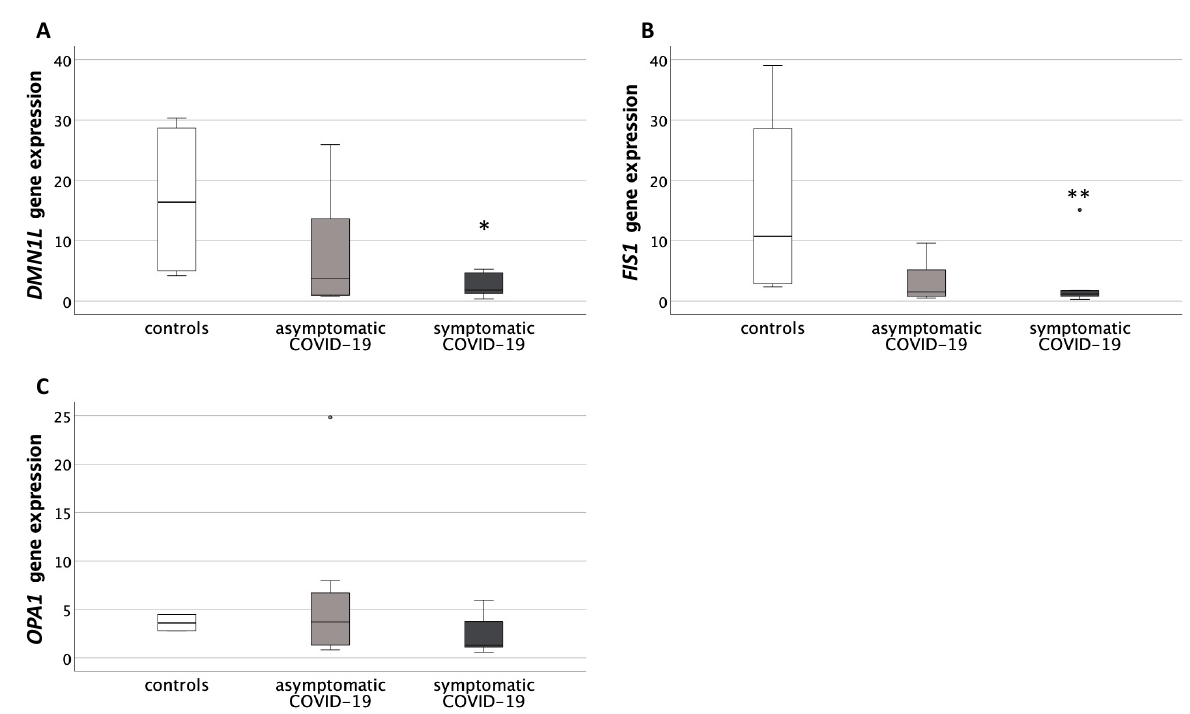
Figure 4. Expression levels of genes related to the mitochondrial dynamics of fusion and fission in placentas from healthy control pregnancies and mothers infected with SARS-CoV-2 during the third trimester of pregnancy. ( A ) Placental Pro-Fission Dynamin-1-like Protein ( DNM1L ) gene expression levels. Data were significantly different among the three groups (Kruskal-Wallis test, p < 0.05). * p < 0.05 vs. controls (Mann-Whitney U test). ( B ) Placental Fission 1 Protein ( FIS1 ) gene expression levels. Data were significantly different among the three groups (Kruskal-Wallis test, p < 0.05). ** p = 0.01 vs. controls (Mann–Whitney U test). ( C ) Placental Pro-Fusion mitochondrial Dynamin-like GTPase ( OPA1 ) gene expression levels. Data were not significantly different among the three groups. Round circles are values that differ of more than 2 standard deviations from the median value.